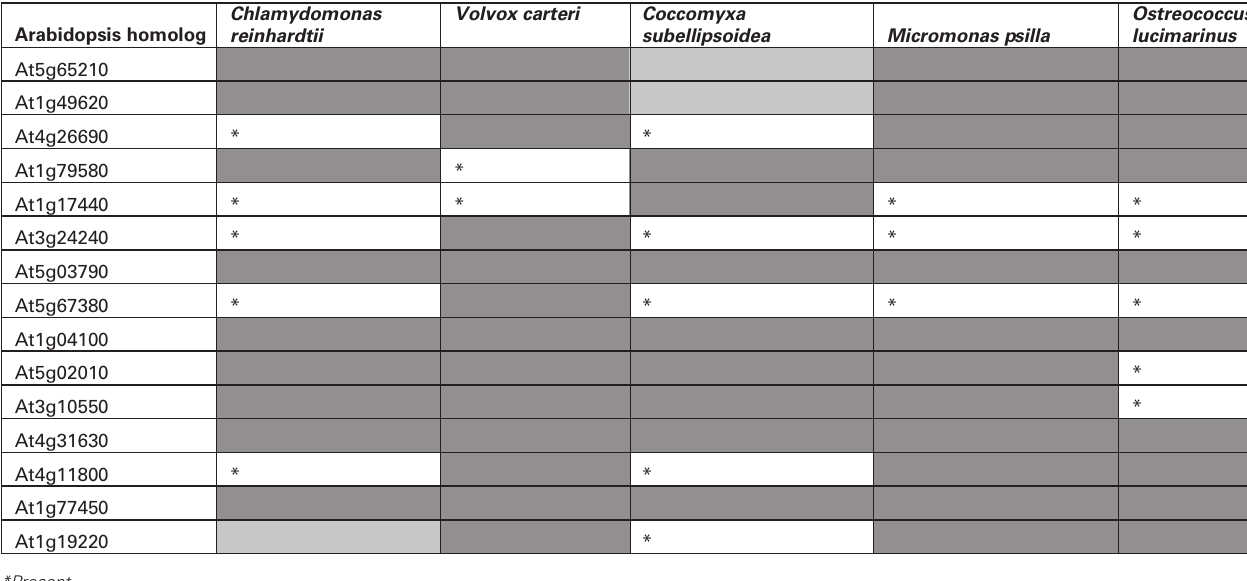
Table 2 | List of Arabidopsis gene homologs not found in chlorophytes. Chlamydomonas Arabidopsis homolog